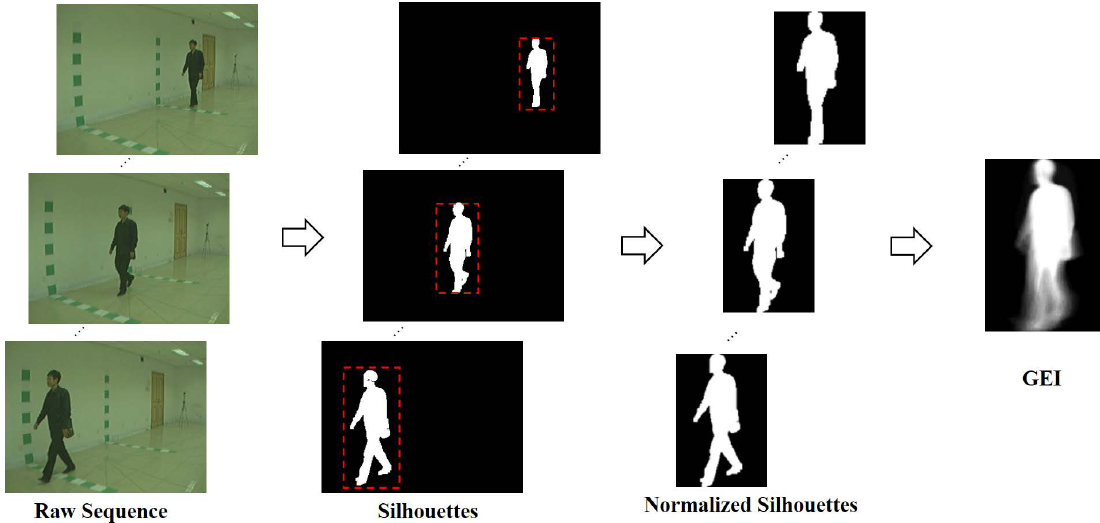
Figure 7: Pipeline of generating GEI.